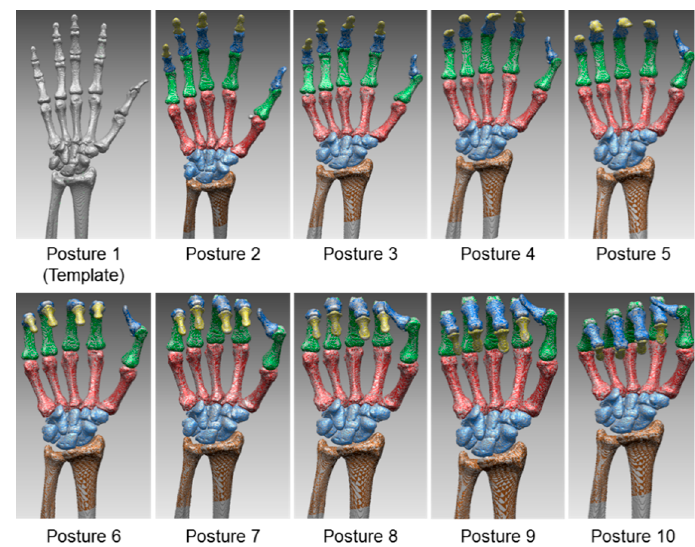
Figure 4. Registration of each bone in the hand skeleton of posture 1 (template posture) to the corresponding bones in the hand skeletons of the other nine postures.